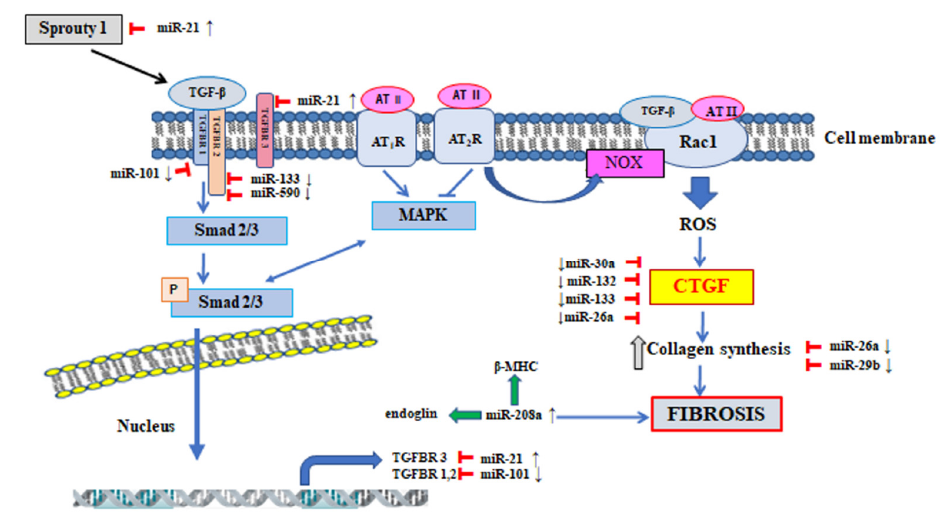
Figure 3. Modulation of signalling pathways by miRNAs in the pathogenesis of atrial fibrosis. ↑ up regulation of miR; ↓ down regulation of miR; ⟙ (red arrow) inhibition; → (green arrow) activation. miR—microRNA; β-MHC—β-myosin heavy chain; Sprouty 1—protein Sprouty homolog 1.